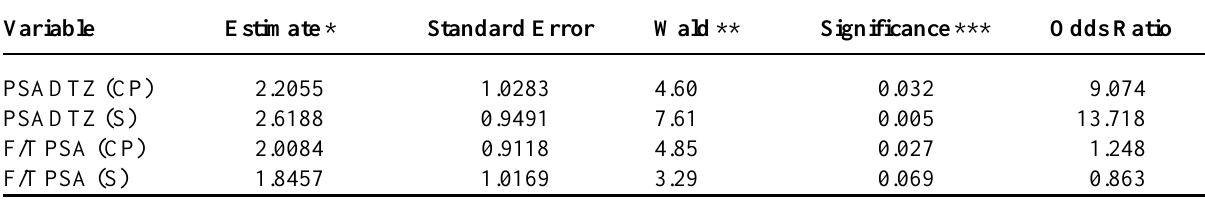
Table 6 – Multivariate analysis by logistic regression considering the best cut-off point (CP) and sensitivity (S) of 90- 95%.